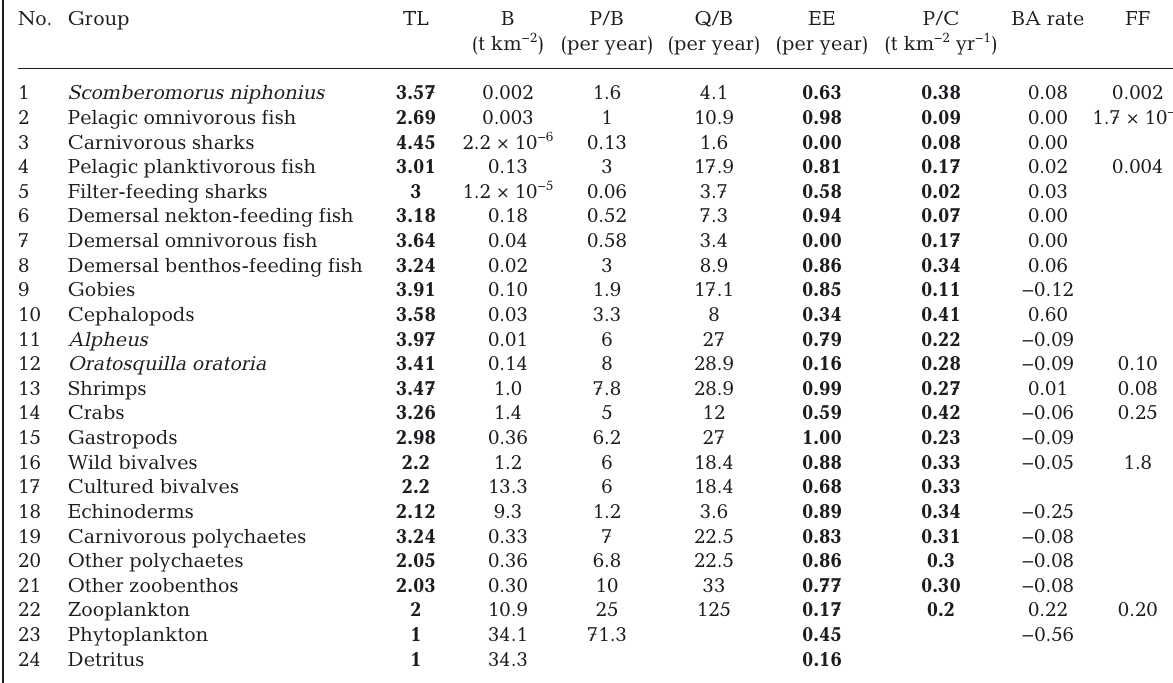
Table 1. Mass-balanced input parameters. Values solved by Ecopath are in bold . TL: trophic level; B: biomass; P/B: pro- duction/biomass; Q/B: consumption/biomass; EE: ecotrophic efficiency; P/C: production/consumption; BA: biomass